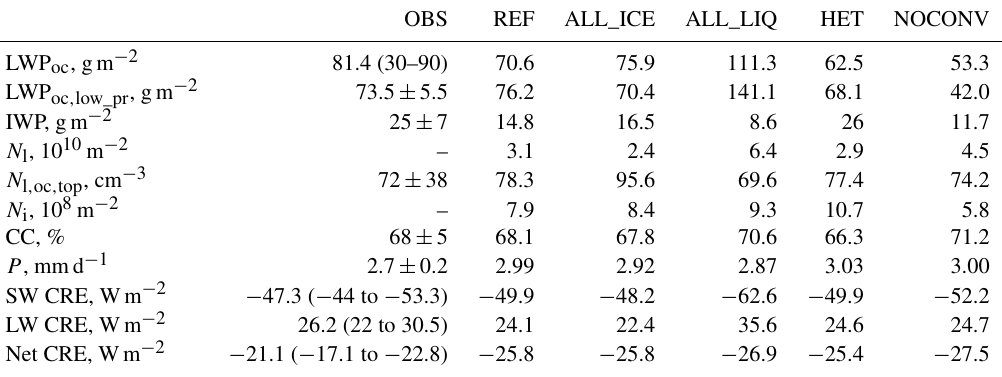
Table 2. Global annual mean of oceanic LWP oc ; LWP oc , low_pr ; IWP; vertically integrated global cloud droplet ( N l ); CDNC at cloud top over oceans ( N l , oc , top ); ice crystal number concentration ( N i ); total cloud cover (CC); precipitation rate ( P ); shortwave (SW), longwave (LW), and net cloud radiative effect (CRE) from observations; and 20-year atmosphere-only present-day model simulations with prescribed SST as described in Table 1 for 2003–2012. The satellite observations of LWP oc are taken from Platnick et al. (2015, 2017), Stengel et al. (2017a), Poulsen et al. (2017), and Elsaesser et al. (2018); of LWP oc , low_pr from Elsaesser et al. (2018); of IWP from the CloudSat/CALIPSO satellites (Li et al., 2012); of N l , oc , top from Bennartz and Rausch (2017) of total cloud cover from Stubenrauch et al. (2013) and Matus and L’Ecuyer (2017); of precipitation rate from the GPCP version 2.3 data set (Adler et al., 2003, 2012). The CRE satellite data are averaged over the period 2001–2011 from the Clouds and the Earth’s Radiant Energy System Energy Balanced and Filled Ed2.6r data set (Boucher et al., 2013) and are described in Loeb et al. (2009, 2018). For the uncertainty range of the SW CRE data from CloudSat and CALIPSO are also considered (Matus and L’Ecuyer, 2017) and for LW CRE data from the TOVS satellite are also considered (Susskind et al., 1997). See legend of Fig. 1 for details of the observations. OBS REF ALL_ICE ALL_LIQ HET NOCONV LWP oc , gm − 2 81.4